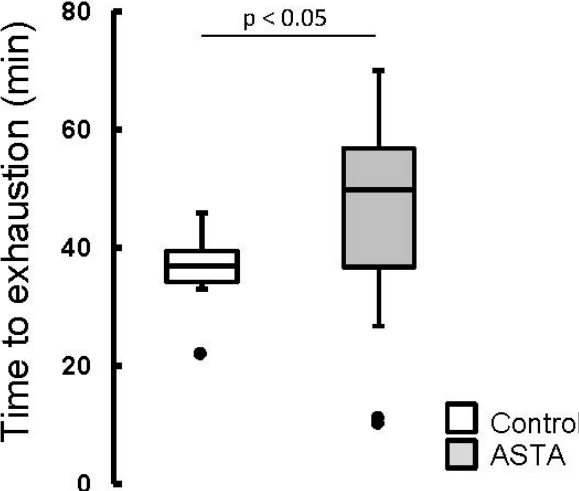
Figure 2. Boxplots of the swimming activity until exhaustion (min) of Wistar rats loaded with additional 5% BW (to force swimming) and supplemented for 45 days with 1 mg ASTA/kg BW or mineral oil (control). ( n ≥ 11, p < 0.05). (•) Outliner data of the IQR = 1.25 × (Q3 − Q1), where: IQR = interquartile range; Q3 = 75% quartile; and Q1 = 25%